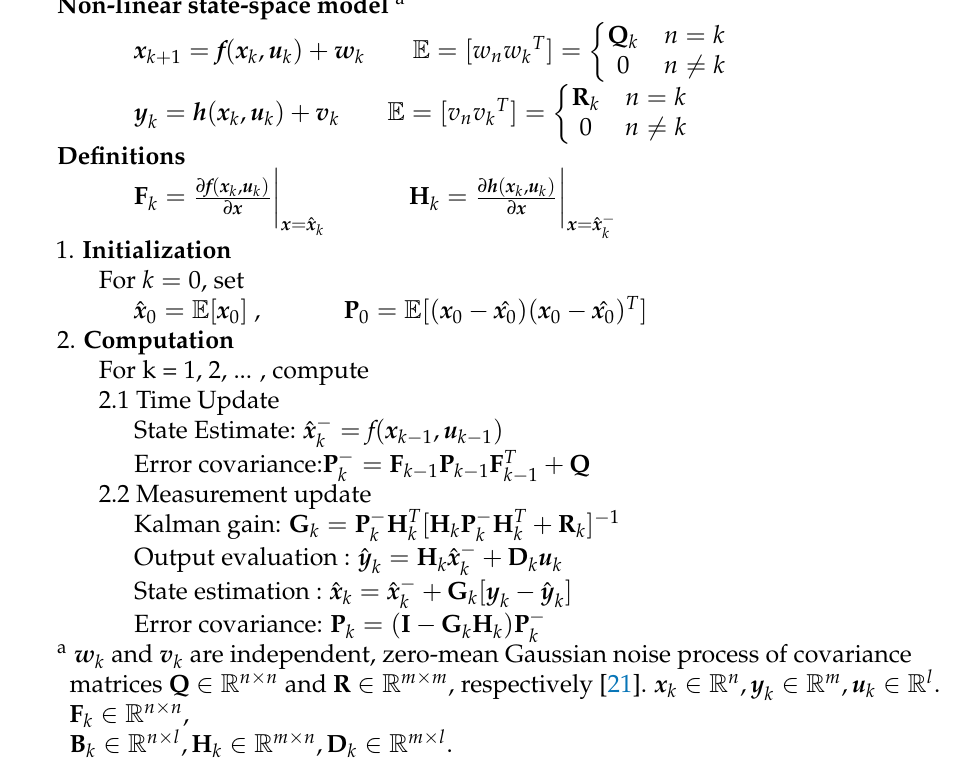
Algorithm 1: Summary of non-linear extended Kalman filter equation. Non-linear state-space model